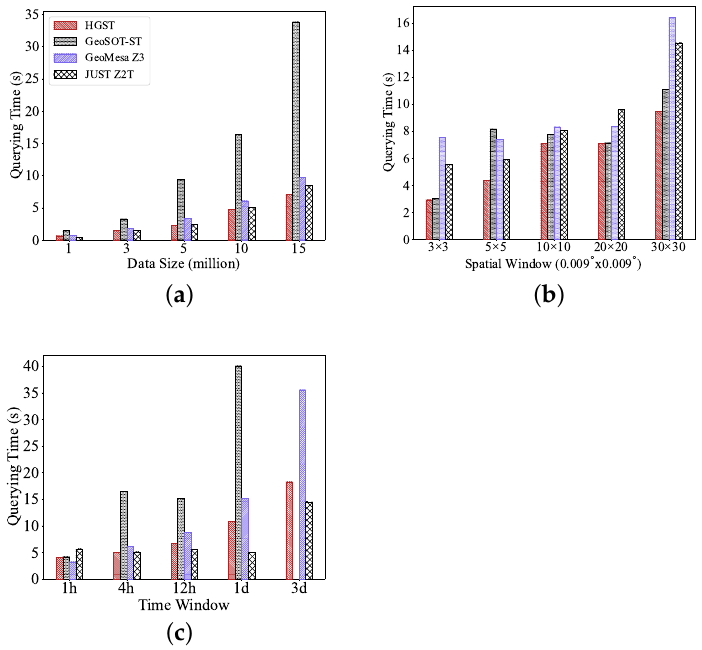
Figure 12. Performance of spatio-temporal range query. ( a ) Spatio-temporal range query under different data sizes. ( b ) Spatio-temporal range query under different spatial windows. ( c ) Spatio- temporal range query under different time windows.